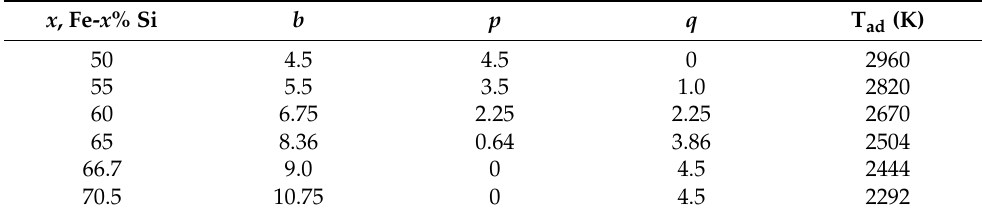
Table 2. Stoichiometric coefficients ( b , p , and q ) and adiabatic temperatures (T ad ) of Reactions (2) under different Si percentages ( x ) in terms of Fe- x %Si. x , Fe- x % Si b p q T ad